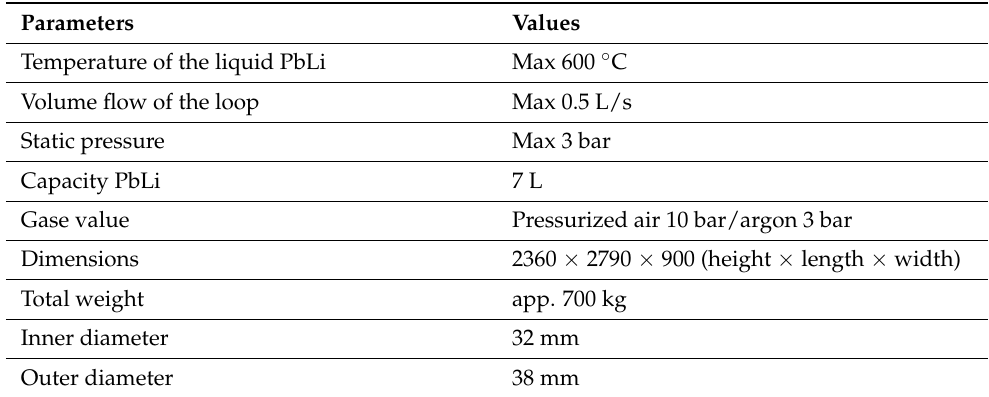
Table 2. Main features of